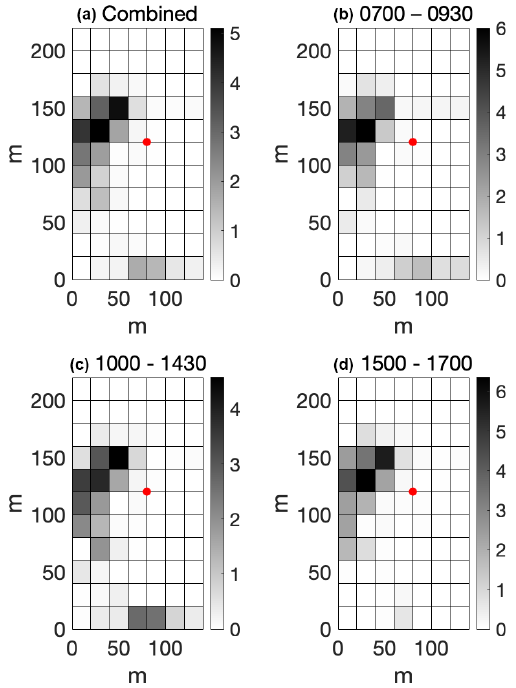
Figure 9. Average proportional bison density for three periods of the day. Each colored pixel represents a 20m grid square; red dots denote the location of the eddy covariance tower; and subplot ti- tles refer to local time. Color denotes the average number of bison present in each grid cell for the 39-animal herd.